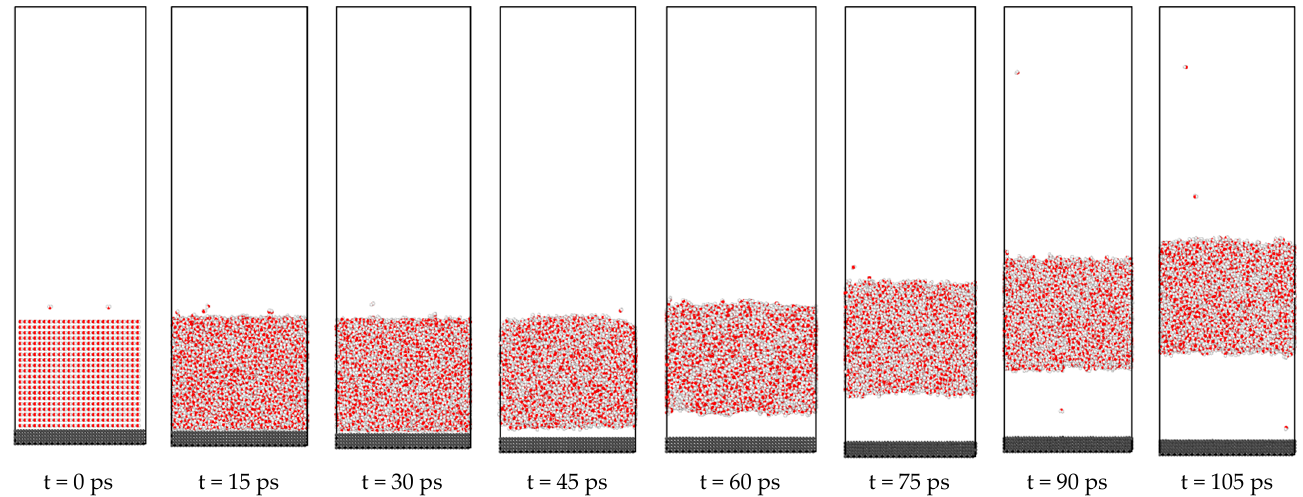
Figure 4. Explosive boiling of water at 500 K temperature.